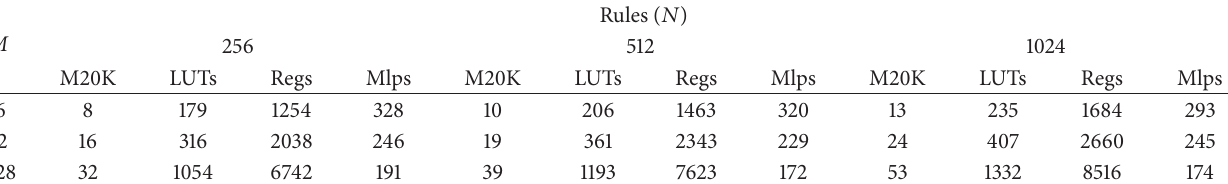
Table 6: Performance of BS and pipelined architecture on FPGA ( 𝑁 ≤ | UR | ≤ 2𝑁